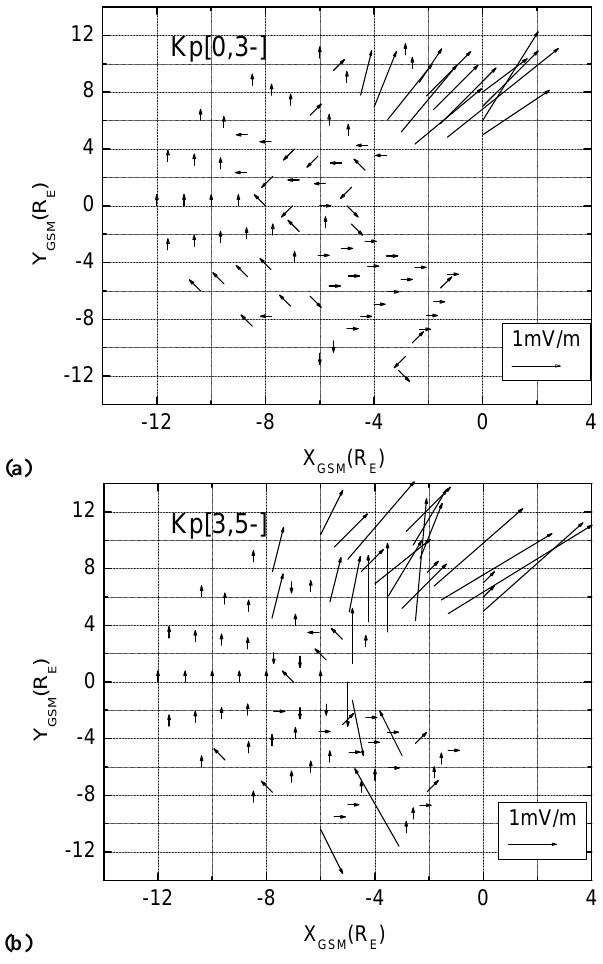
Fig. 4. (a) The electric field vector in equatorial plane for Kp be- tween 0 and 3 − . (b) The electric field vector in equatorial plane for Kp between 3 and 5 − .